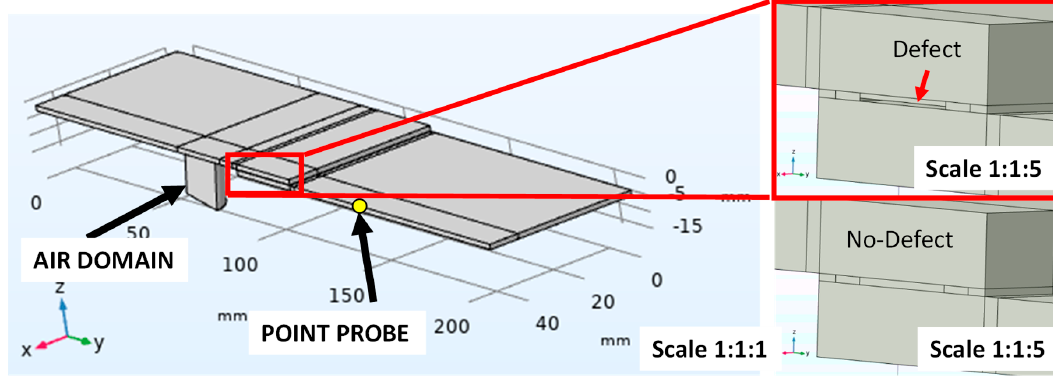
Figure 7. One-half of the symmetric model with two cases: one with the defect, and one without